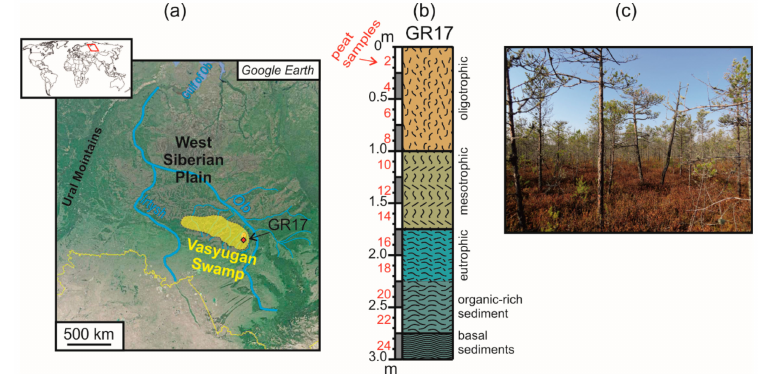
Figure 1. Map of the studied peat bog location ( a ) stratigraphy of the studied core ( b ) and photo of the studied pine-shrub-sphagnum bog ( c ) Oligotrophic peat (0–1 m) consists of Sphagnum fuscum , mesotrophic peat (up to 1.75–1.8 m) depth is comprised of Sphagnum magellanicum peat, eutrophic peat (1.8–2.25 m) and organic-rich sediment (2.25–2.75 m) consist of Sphagnum jensenii and woody peat, and the basal sediments (from 2.75) are presented by